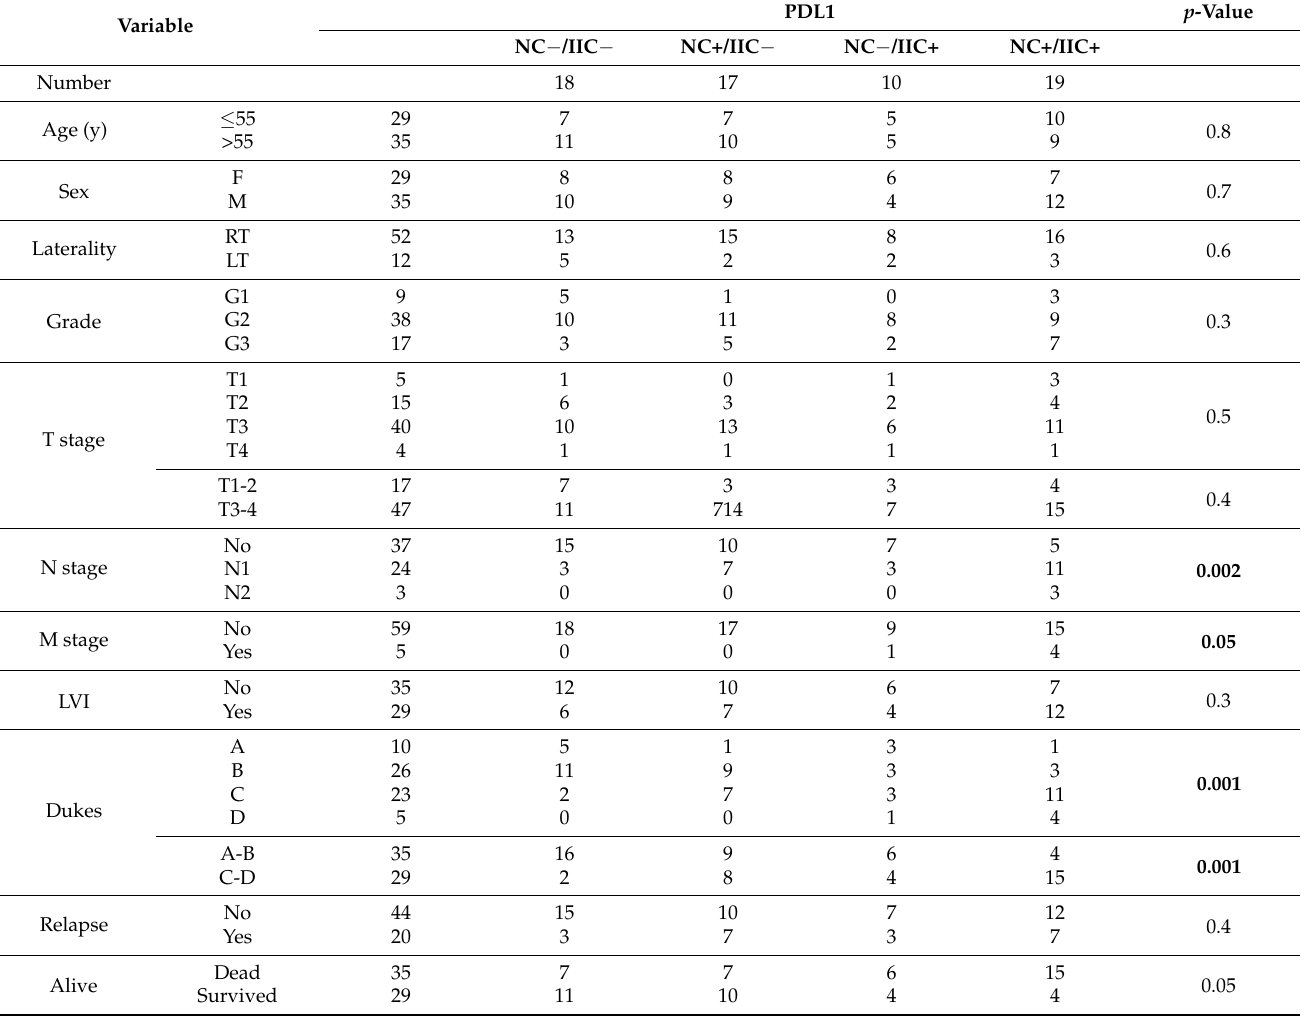
Table 4. Association of combined expression patterns of PDL-1 in NC and IIC and clinicopathological prognostic factors of colon